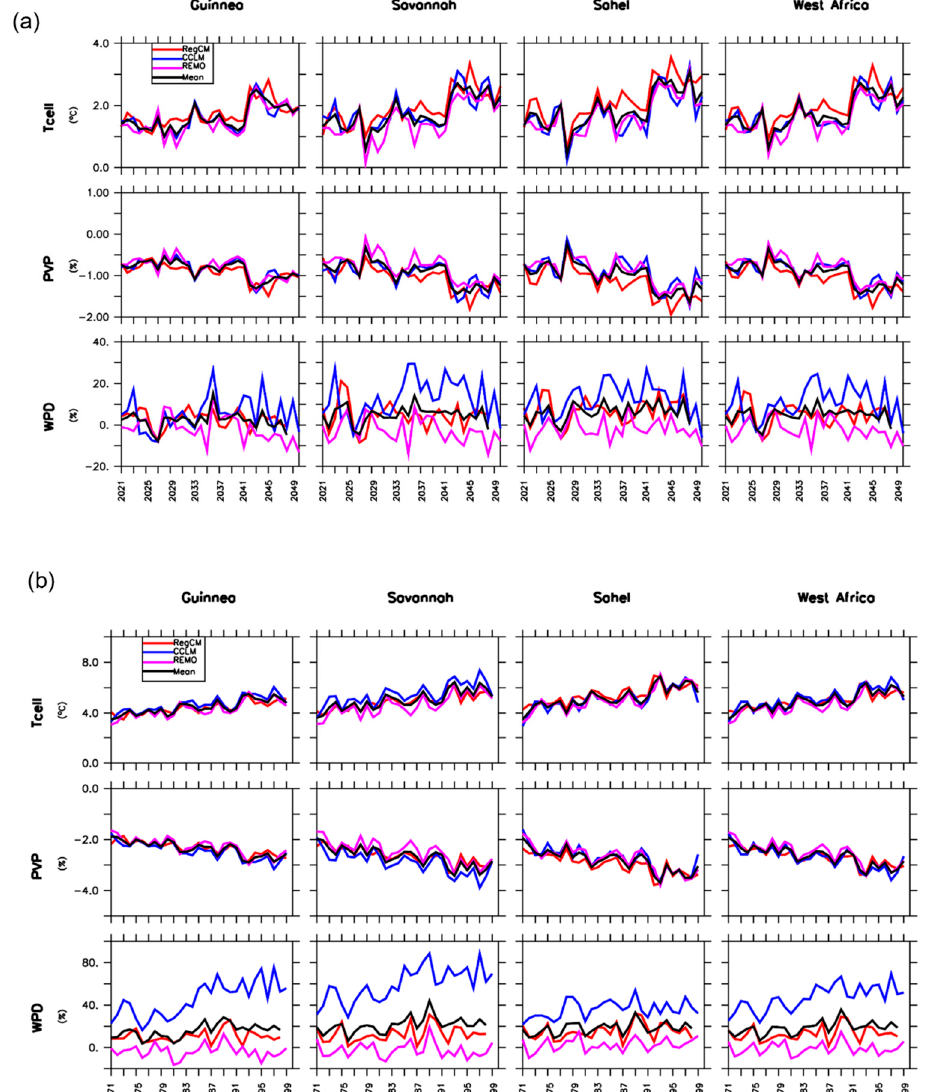
Figure 12. Inter-annual variability of the projected changes of the cell temperature (Tcell) and the solar and wind potential (PVP and WPD respectively) over the climatic zones of West Africa for the near future ( a ) (2021–2050) and far future ( b ) (2071–2100) and under the RCP8.5 scenario.